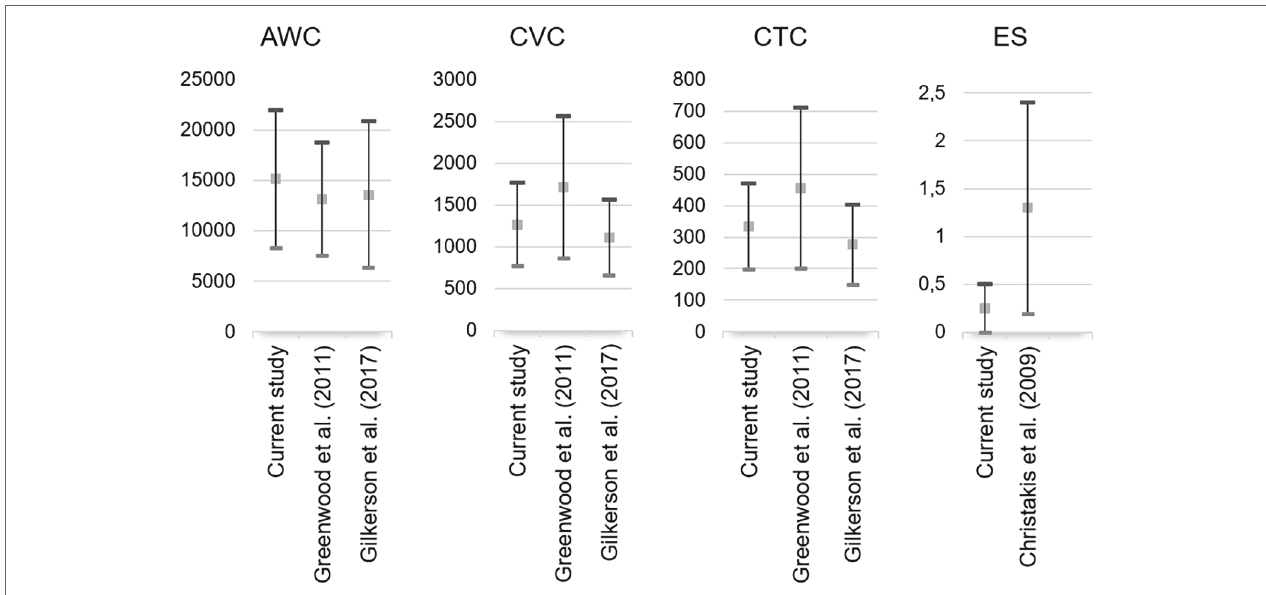
FIGURE 1 | Language ENvironment Analysis (LENA) variables compared with previous studies. The square illustrates the mean, and the whiskers illustrate the standard deviations. AWC, adult word count; CVC, child vocalization count; CTC, conversational turn count; ES, electronic sound. Note that the scale on the y-axis differs between variables.